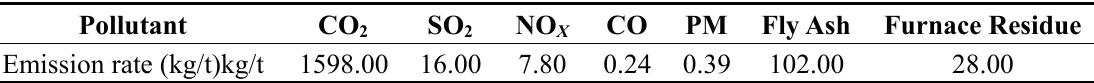
Table 4. Pollutant emission rate for a 600 MW coal-fired power